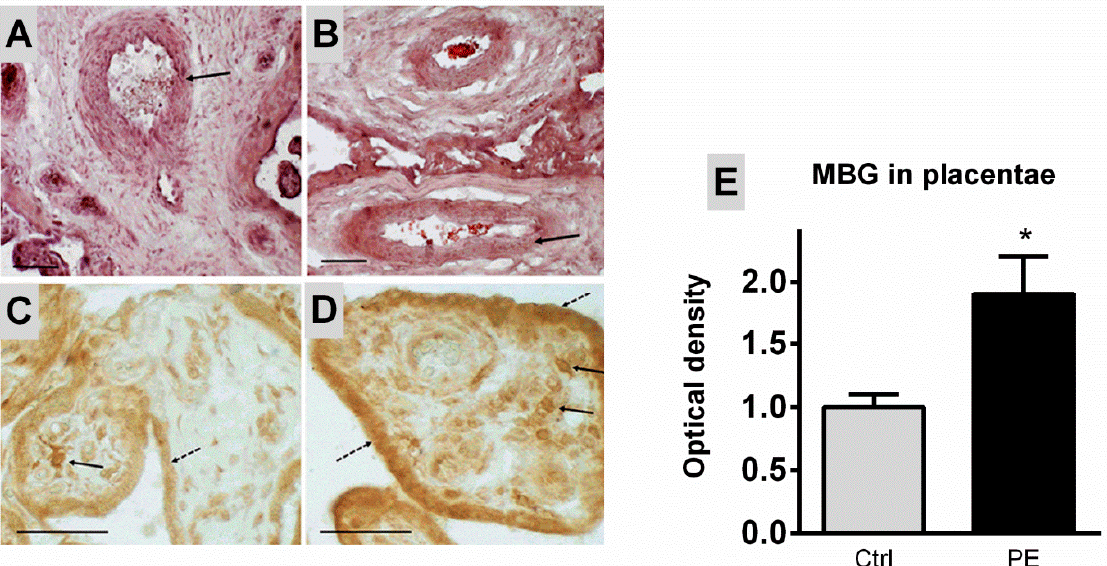
Figure 1. Arteries in the chorionic villi of the placenta in healthy pregnant subjects ( A ) and patients with PE ( B ). Arrows point to the muscular layer of the arteries. Stained with hematoxylin and eosin, scale bars 200 μ m. Immunohistochemical staining with anti-MBG antibodies in the placenta of healthy subjects ( C ) and patients with PE ( D ); results of quantitative analysis of the optical density of MBG in the cytotrophoblast of the chorionic villi ( E ). Solid arrows —the reaction in the cells of the chorionic villi, dashed arrows —the reaction in the trophoblast of the chorionic villi. In panel E–data are presented in arbitrary units (a.u.), *—the reliability of the difference from the control ( p < 0.05). Scale 200 μ m ( A , B ), 100 μ m( C , D ).